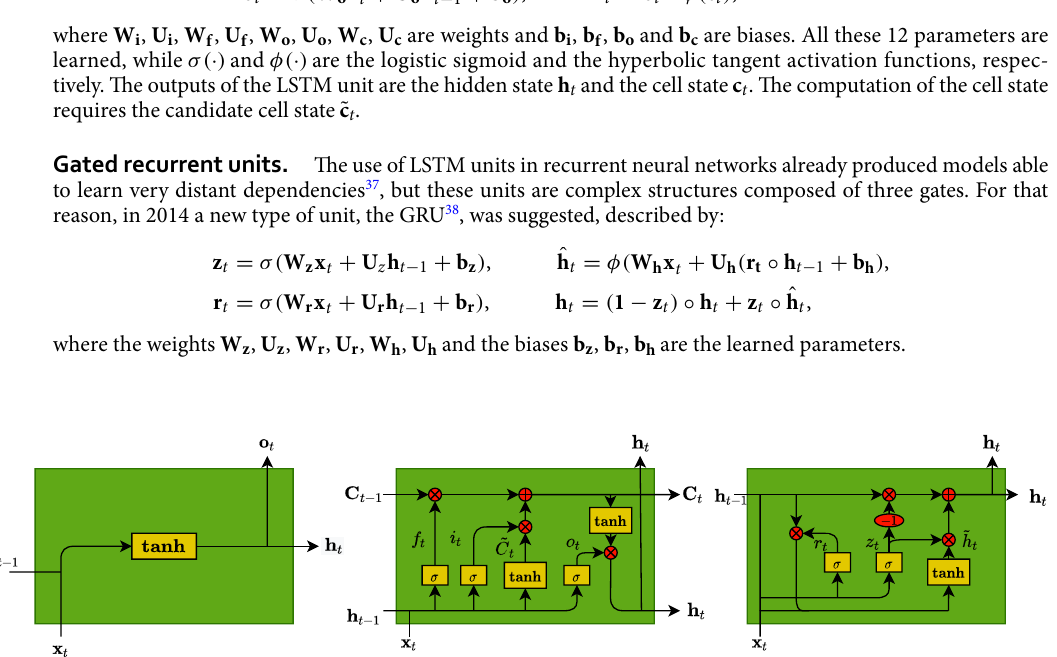
Figure 3. Comparison between the three different units: RNN, LSTM and